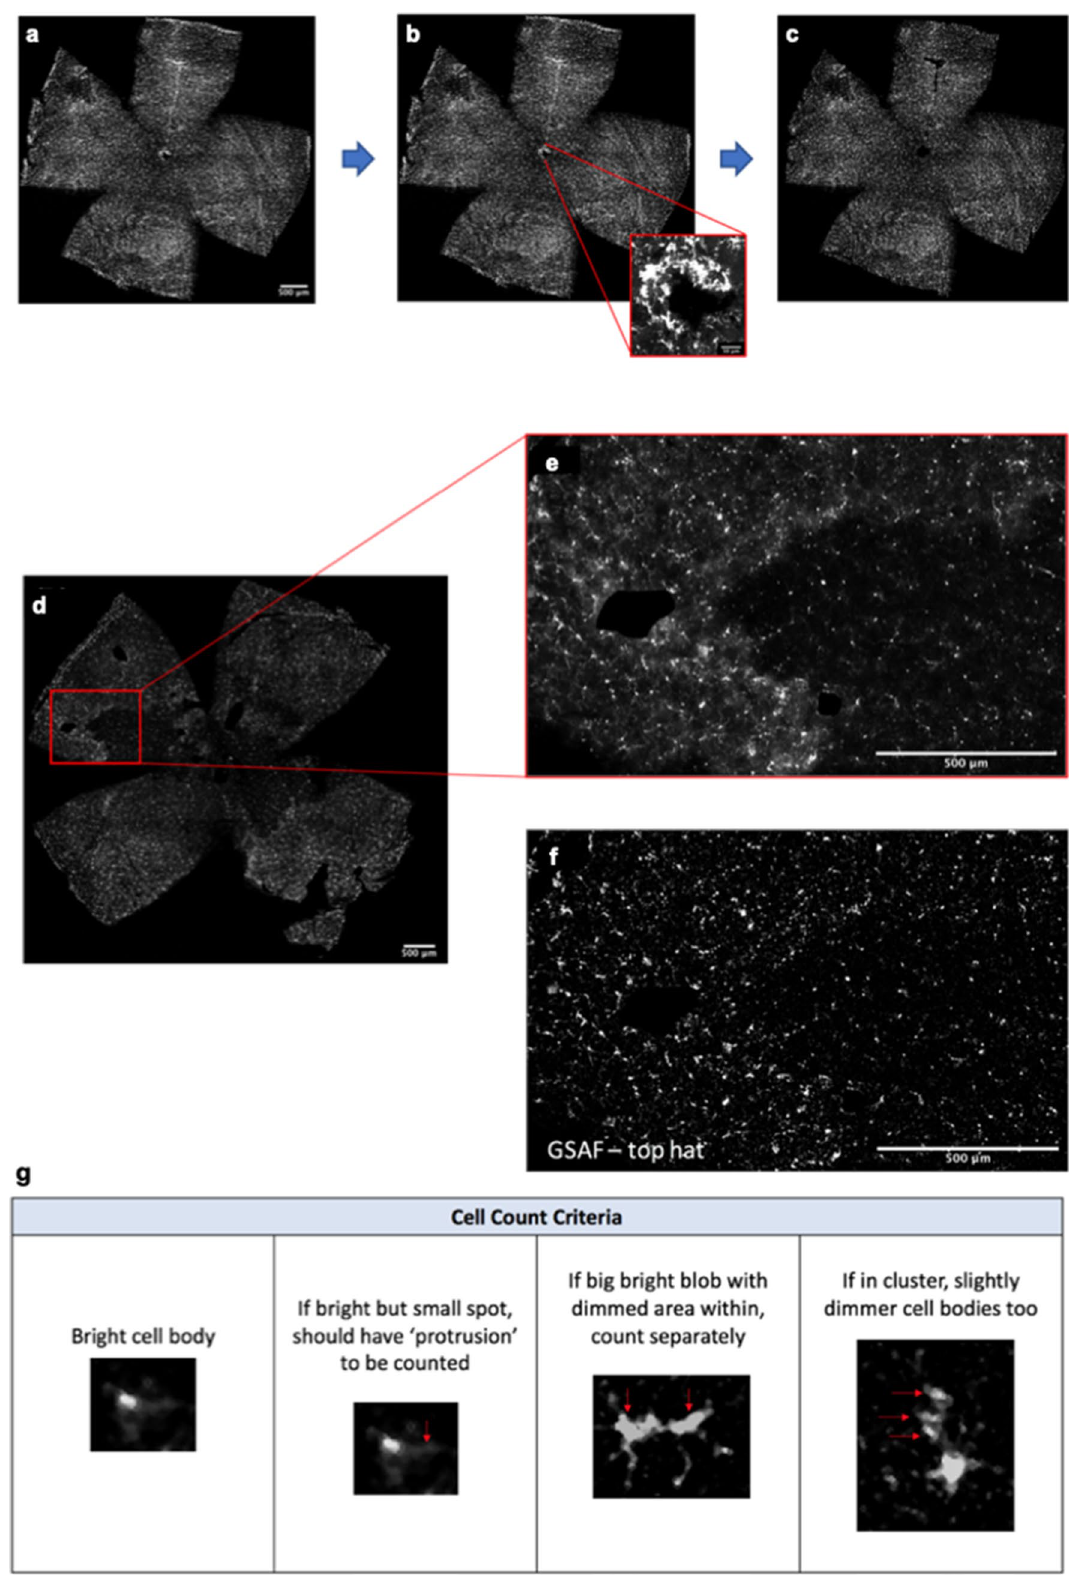
Figure 6. CBCS Development process. ( a – c ) shows the artefact removal process where ( a ) shows regions of oversaturated staining especially near the optic nerve head ( b ) and the edges of the retina. ( c ) shows artefacts having been removed to prevent skewing of results due to the oversaturated areas. ( d ) shows the original image with a zoomed section ( e ) showing uneven staining. This was greatly improved by the GSAF function with top hat as seen in ( f ). ( g ) shows the cell count criteria that were utilised to ensure for a consistent counting method between each observer. Scale bars represent 500 μm in ( a , d , e , f ) and 50 μm in ( b ). GSAF Gray Scale Attribute